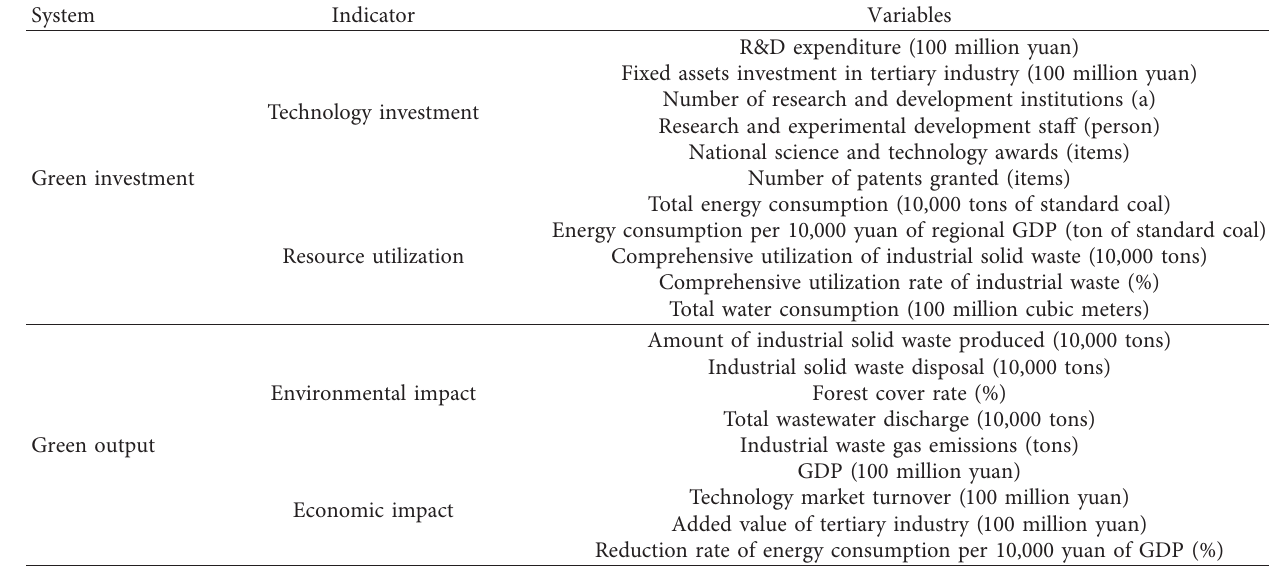
Table 2: Index system.